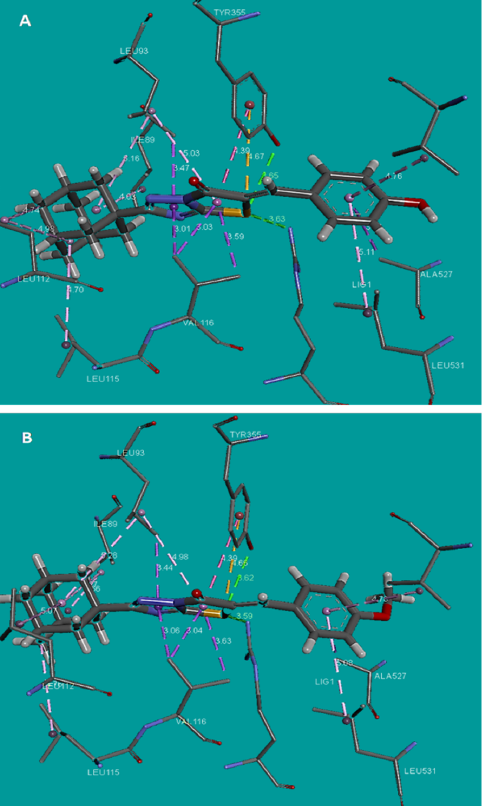
Figure 2. ( A ) Binding of compound 3 into the active site of COX–1, ( B ) Binding of compound 8 into the active site of